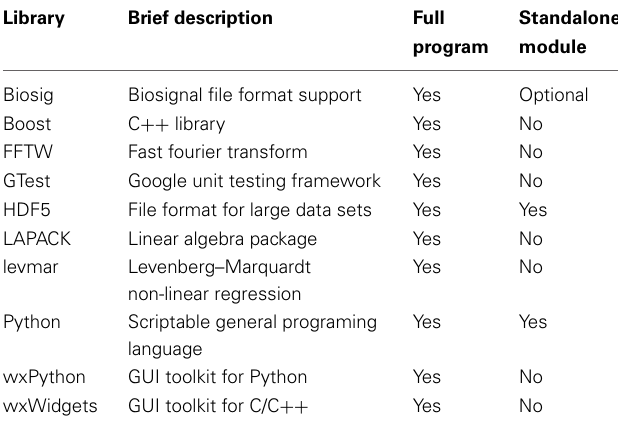
Table 4 | List of C ++ external